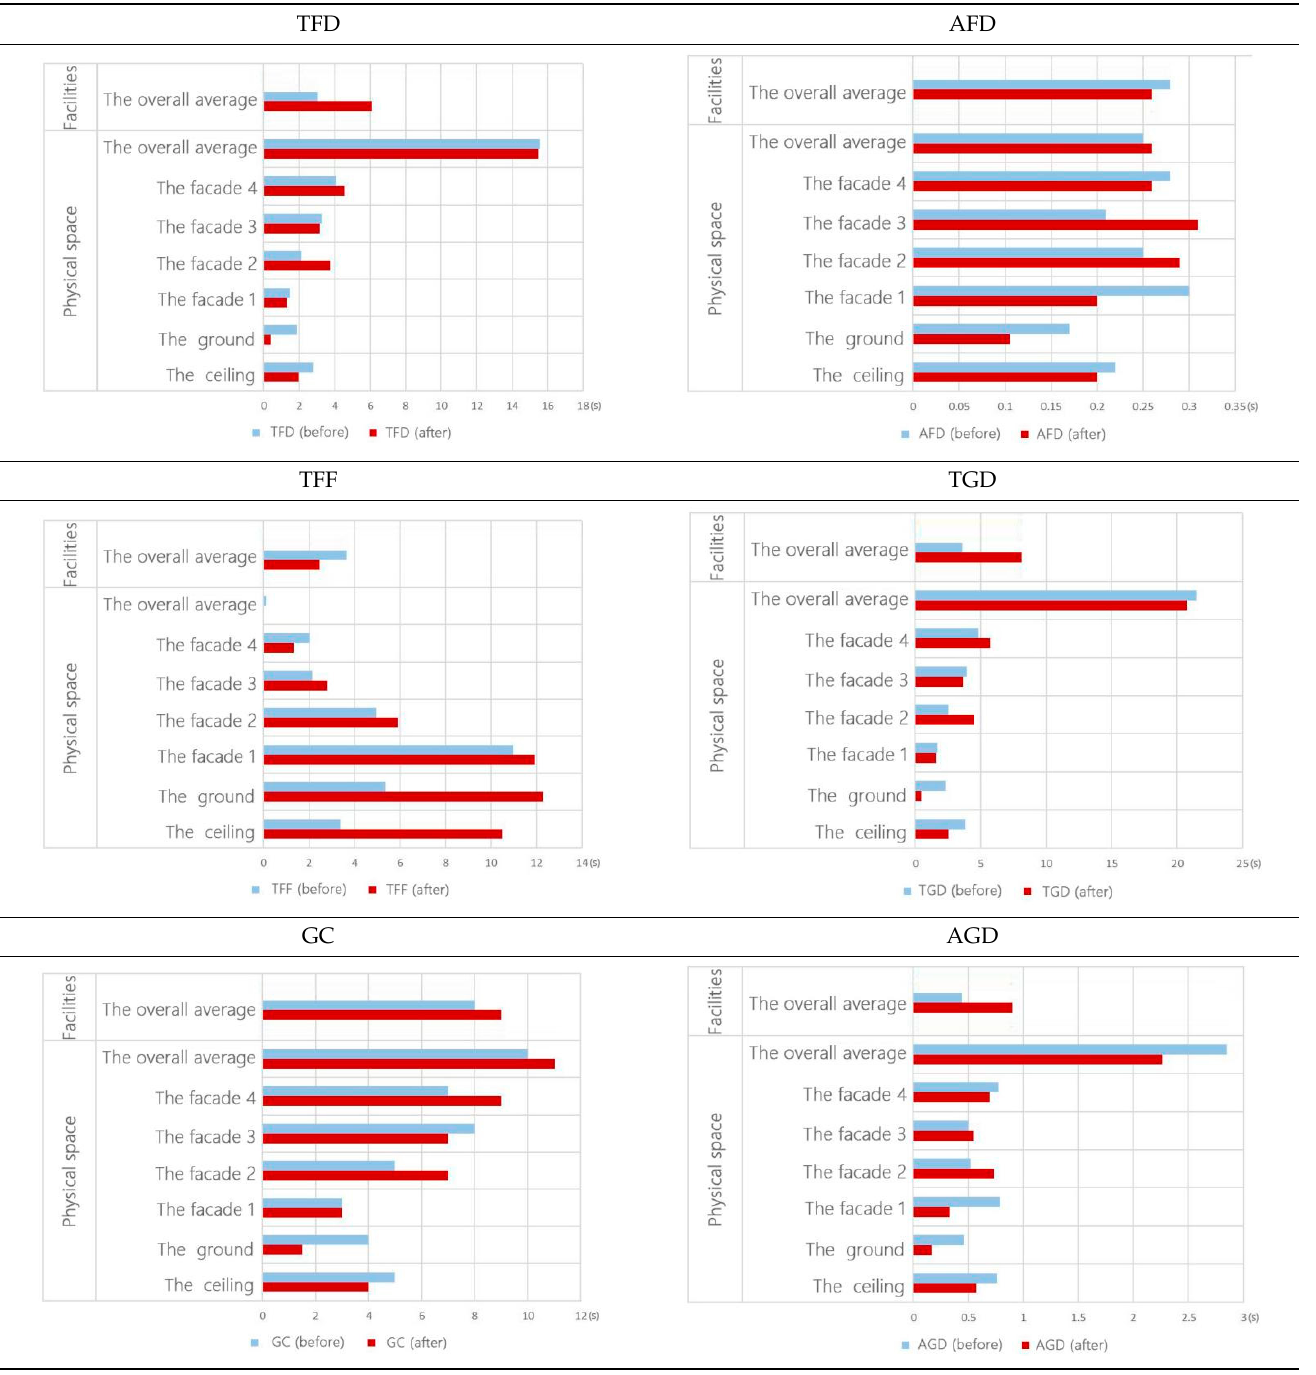
Table 2. Comparison of eye-tracking data of the first-floor cafe before and after optimization.